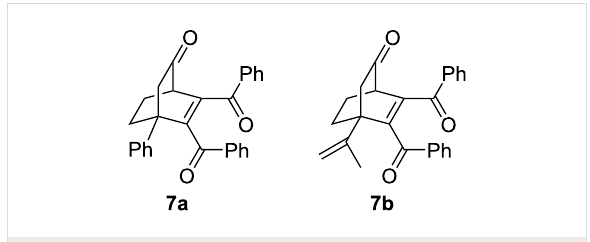
Figure 2: Enones used for this